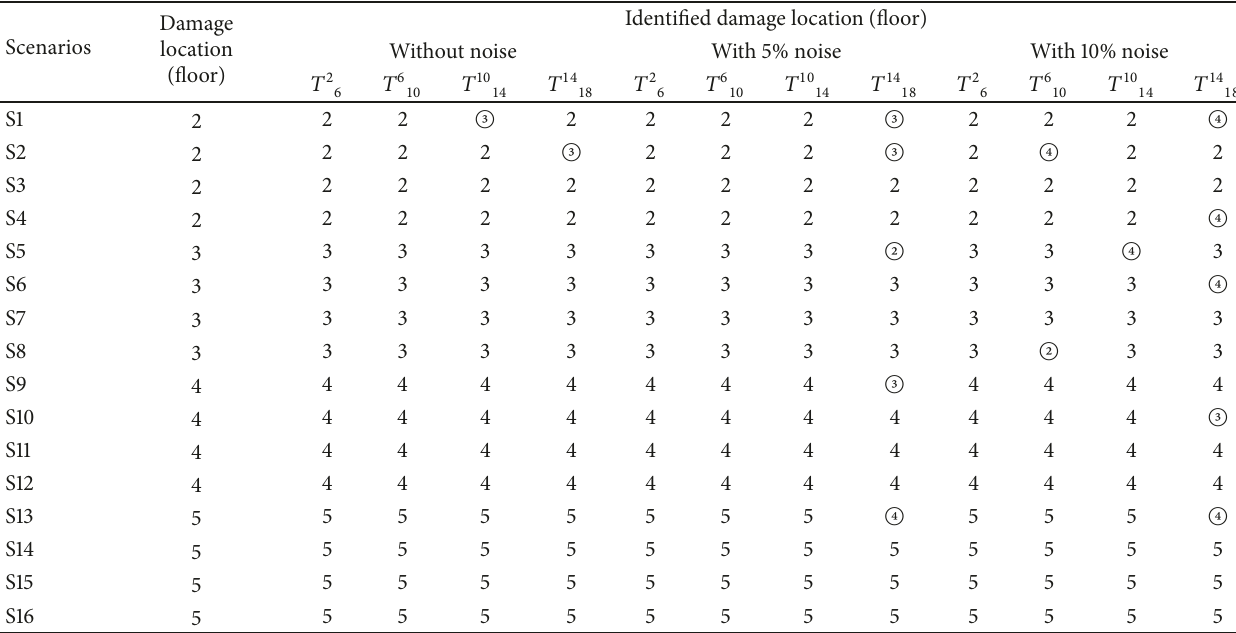
Table 6: Identified damage locations based on PC and SVM.